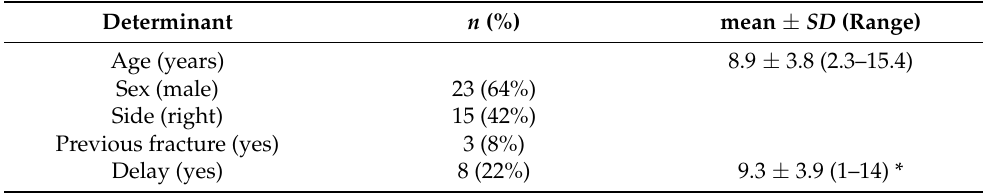
Table 1. Characteristics of the included patients ( n = 36).